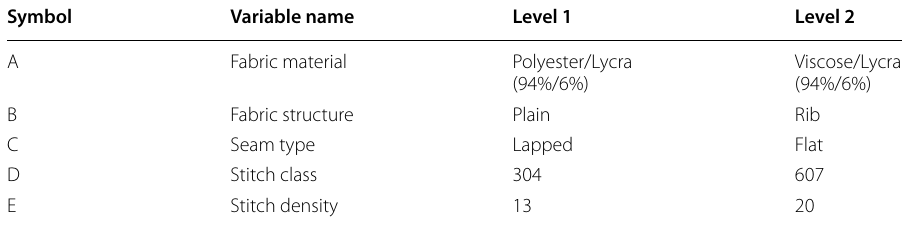
Table 2 Taguchi levels used for this study